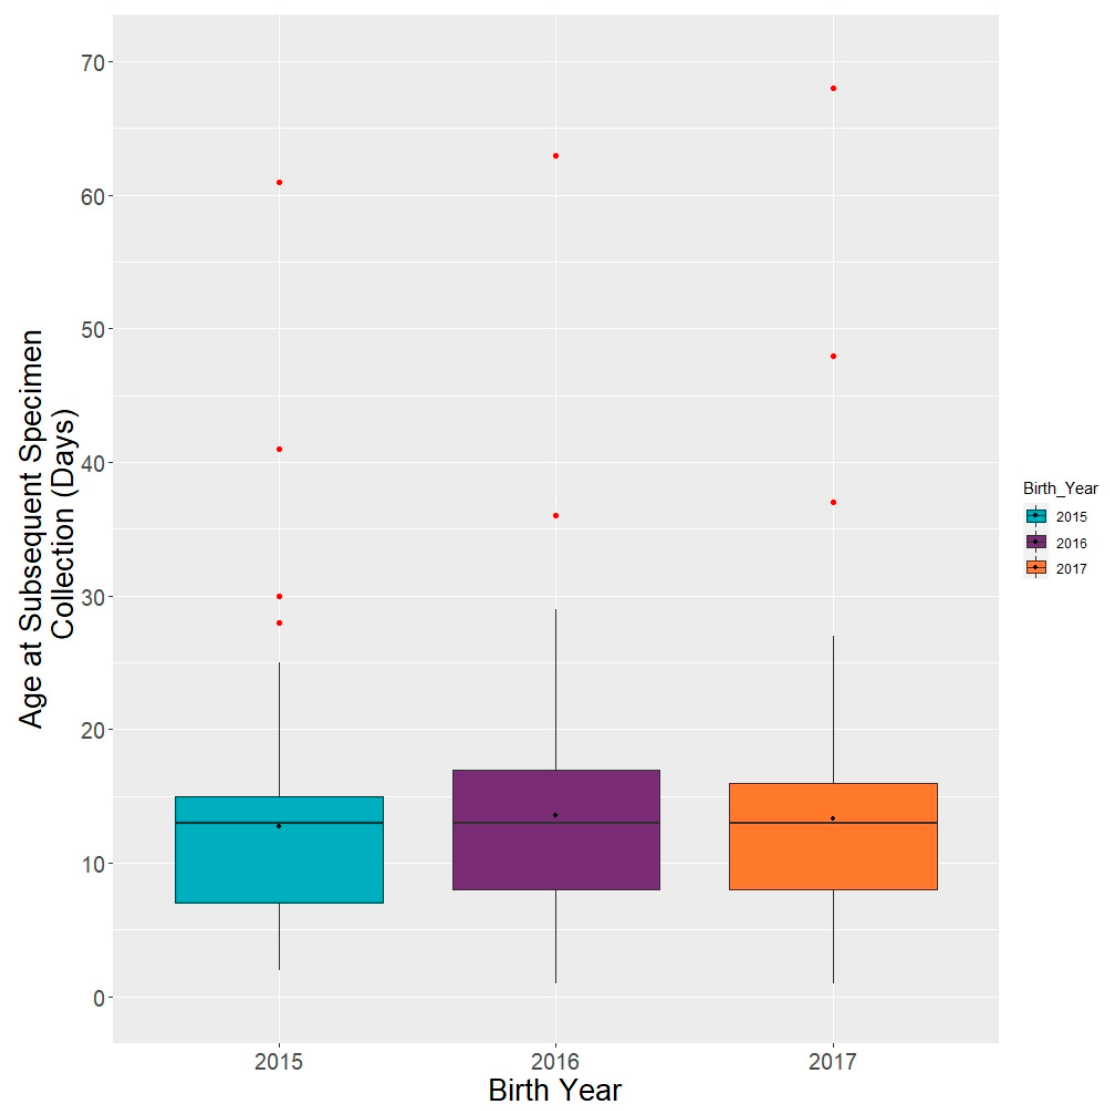
Figure 9. Congenital adrenal hyperplasia cases: age at subsequent specimen collection ( N =